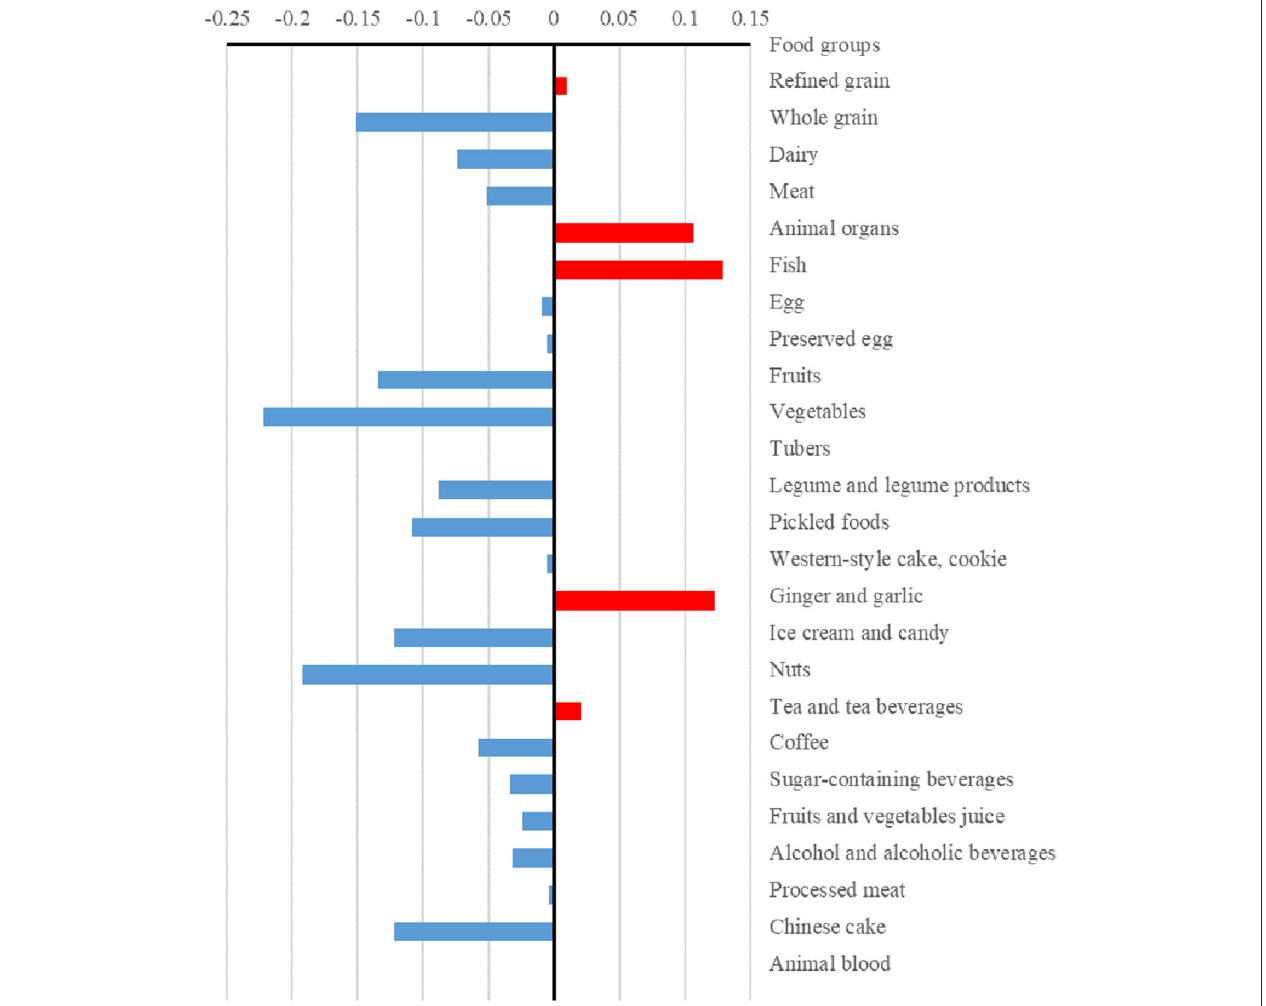
FIGURE 4 | Differences in the hubs of food groups between case and control dietary topologies. For each node, hub was defined as the principal eigenvector of t ( A ), where A is the adjacency matrix of the graph. The hub can describe the importance of a node considering both itself and all connected nodes, which was A × computed via an iterative algorithm that maintains and updates numerical weights for each node. The differences in hubs for food nodes calculated by subtracting control values from case